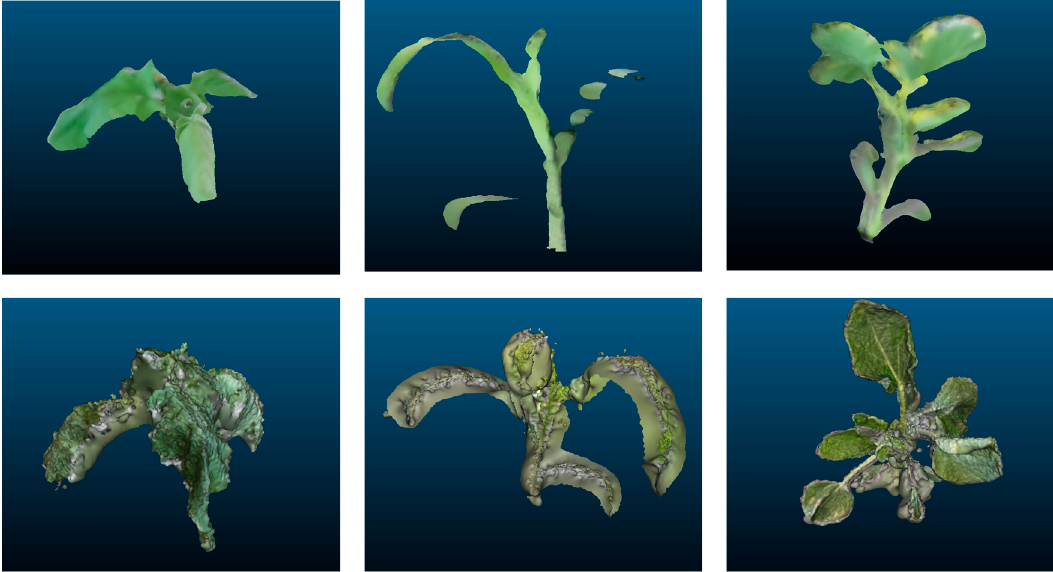
Figure 2. Examples from different perspectives of different crop models reconstructed using Kinect v2 ( top ) and photogrammetry ( bottom ) reconstruction methods.